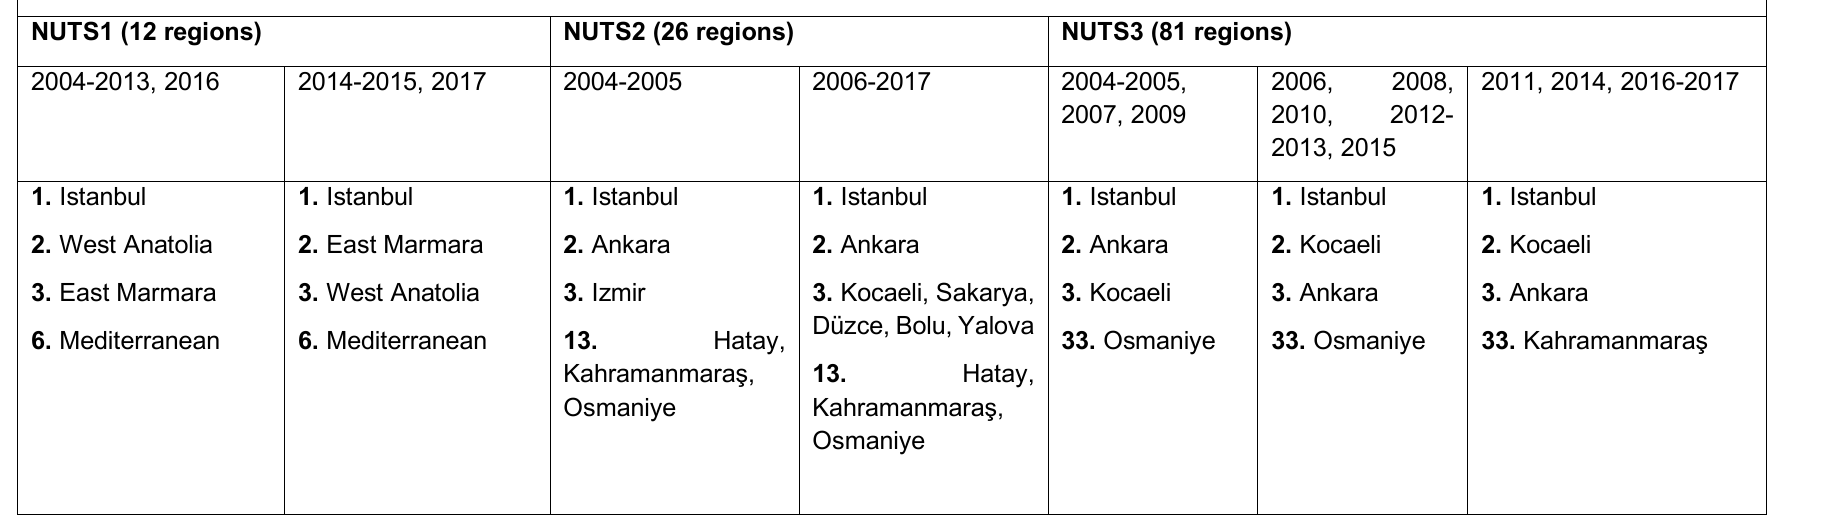
Table C.2: Ranking